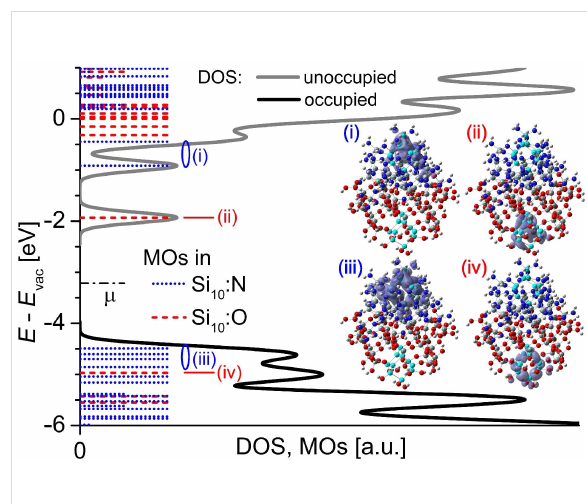
Figure 1: Energy offsets with SiO 2 - and Si 3 N 4 -embedding for one Si 10 -NC (0.8 nm size) embedded in SiO 2 and the other Si 10 -NC em- bedded in Si 3 N 4 within one approximant. The main graph shows the electronic DOS. MOs localized in Si 3 N 4 - (SiO 2 -) embedded Si-NC are shown in blue (red); the reduced length of the MOs corresponds to partial localization in Si 10 -NC, with the remainder of the MO being localized within the dielectric. The chemical potential of the entire approximant μ is shown as a dashed-dotted line. Graphs (i) to (iv) show iso-density plots (1 × 10 − 3 states/ a 03 = 6.76 states/nm 3 ) of fron- tier MOs marked by (i) to (iv) in the DOS plot. Si 10 -NCs are shown in cyan, Si in SiO 2 and Si 3 N 4 in grey, O in red, N in blue and H in white.